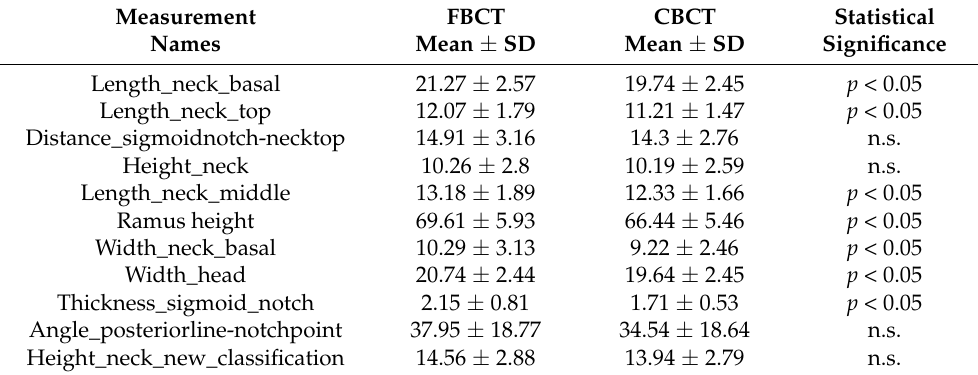
Table 2. Obtained measurement results of the condylar process of the mandible in the two radiological imaging